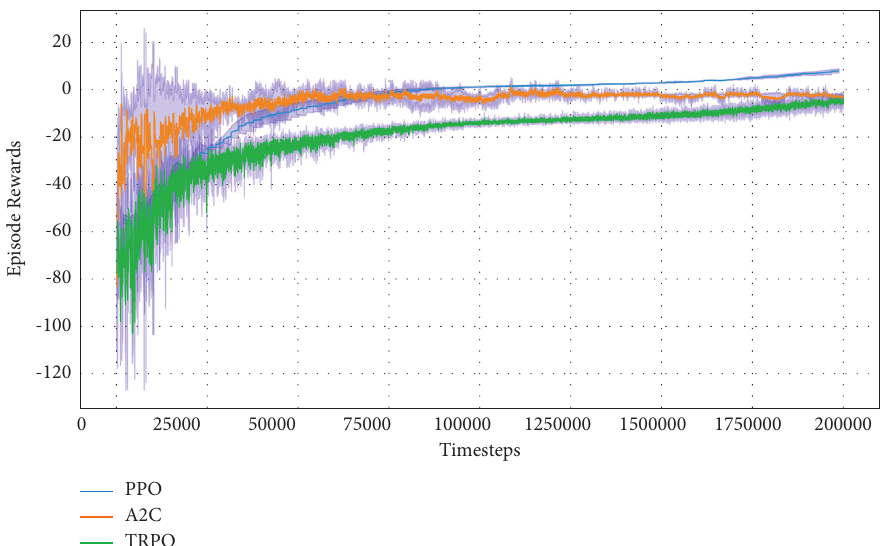
Figure 10: Learning curves for the fighter-decoy scenario. The shaded region represents a standard deviation of average evaluation over three trails.